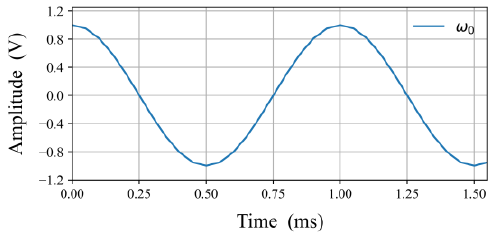
Figure 5. LUT values of the oscillator cos ω 0 implemented in VHDL.